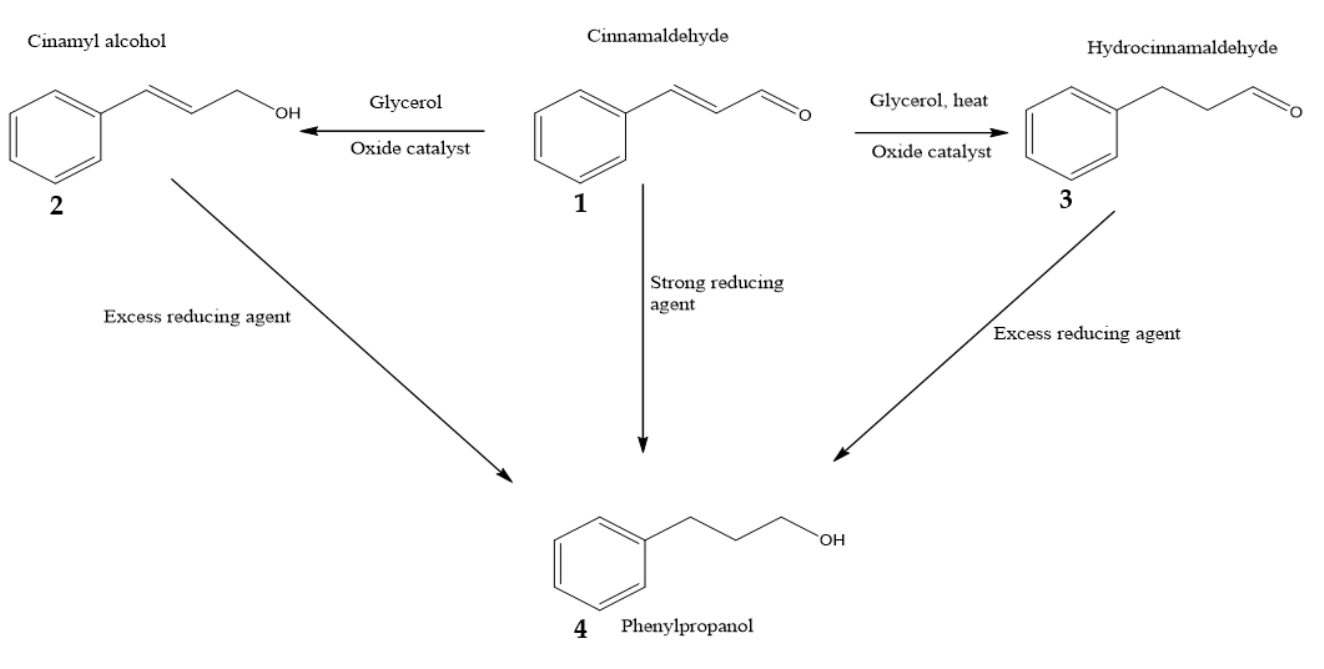
Scheme 1. Hydrogenation of cinnamaldehyde to various products in the presence of oxide